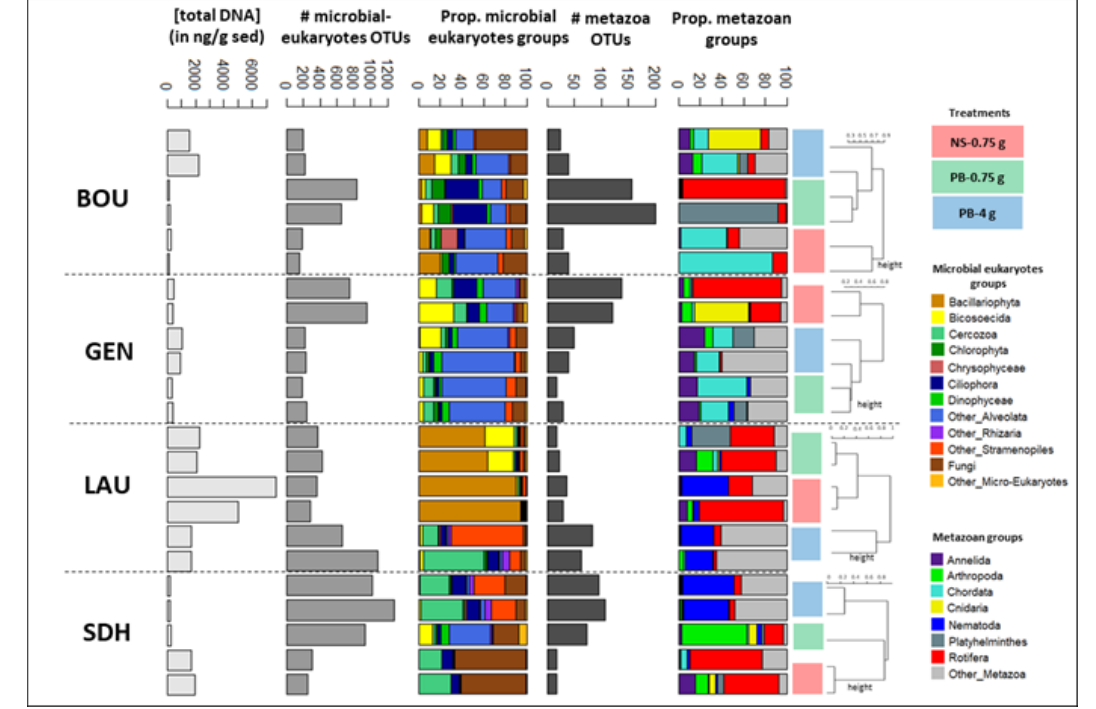
Figure A3. This figure describes, for each sample, the total DNA concentration (in ng.g sed −1 ), number of microbial eukaryotic and metazoan MOTUs, proportion of reads from microbial eukaryotes and metazoan groups. Samples were obtained from two large (>44 km 2 ) deep peri-alpine lakes (Bourget (LDB), Geneva (LEM)) and two small (<0.1 km 2 ), shallow, high-altitude lakes (Lauzanier (LAZ), Serre de l’Homme (SDH)). A code color discriminates between the three DNA extraction treatments (red color for NS-0.75g, green for PB-0.75g and blue for PB-4g). For each lake, hierarchical clustering analysis was independently performed from the total MOTU abundance table for all DNA inventories. NS—NucleoSpin protocol, PB—Taberlet2012 protocol.